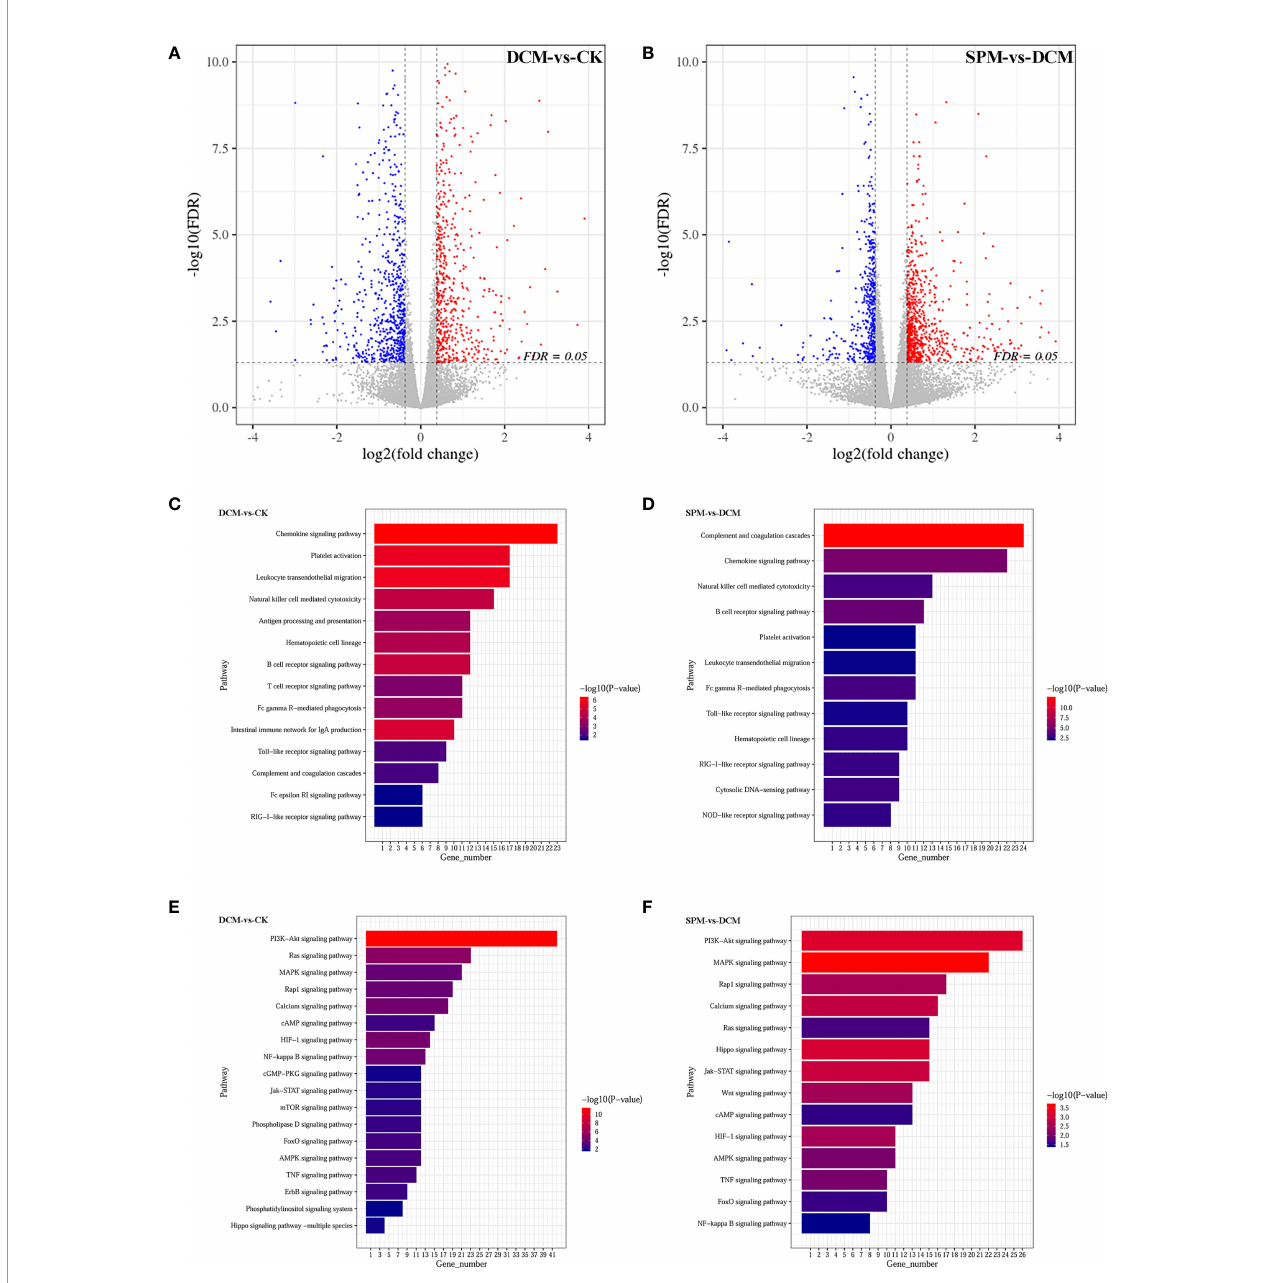
FIGURE 1 | The gene expression pro fi ling and enrichment for myocardium of CK, DCM, and SPM mice. Volcano plot indicates upregulated (red) and downregulated (blue) differentially expressed genes (DEGs) in (A) DCM compared to CK group and (B) SPM compared to DCM group. Each point represents a gene. KEGG column charts shows DEGs enriched in immunity-related pathway of (C) DCM compared to CK group and (D) SPM compared to DCM group. KEGG column charts shows the DEGs enriched in signal transduction pathway of (E) DCM compared to CK group and (F) SPM compared to DCM group. Numbers and p-values of DEGs in each pathway are